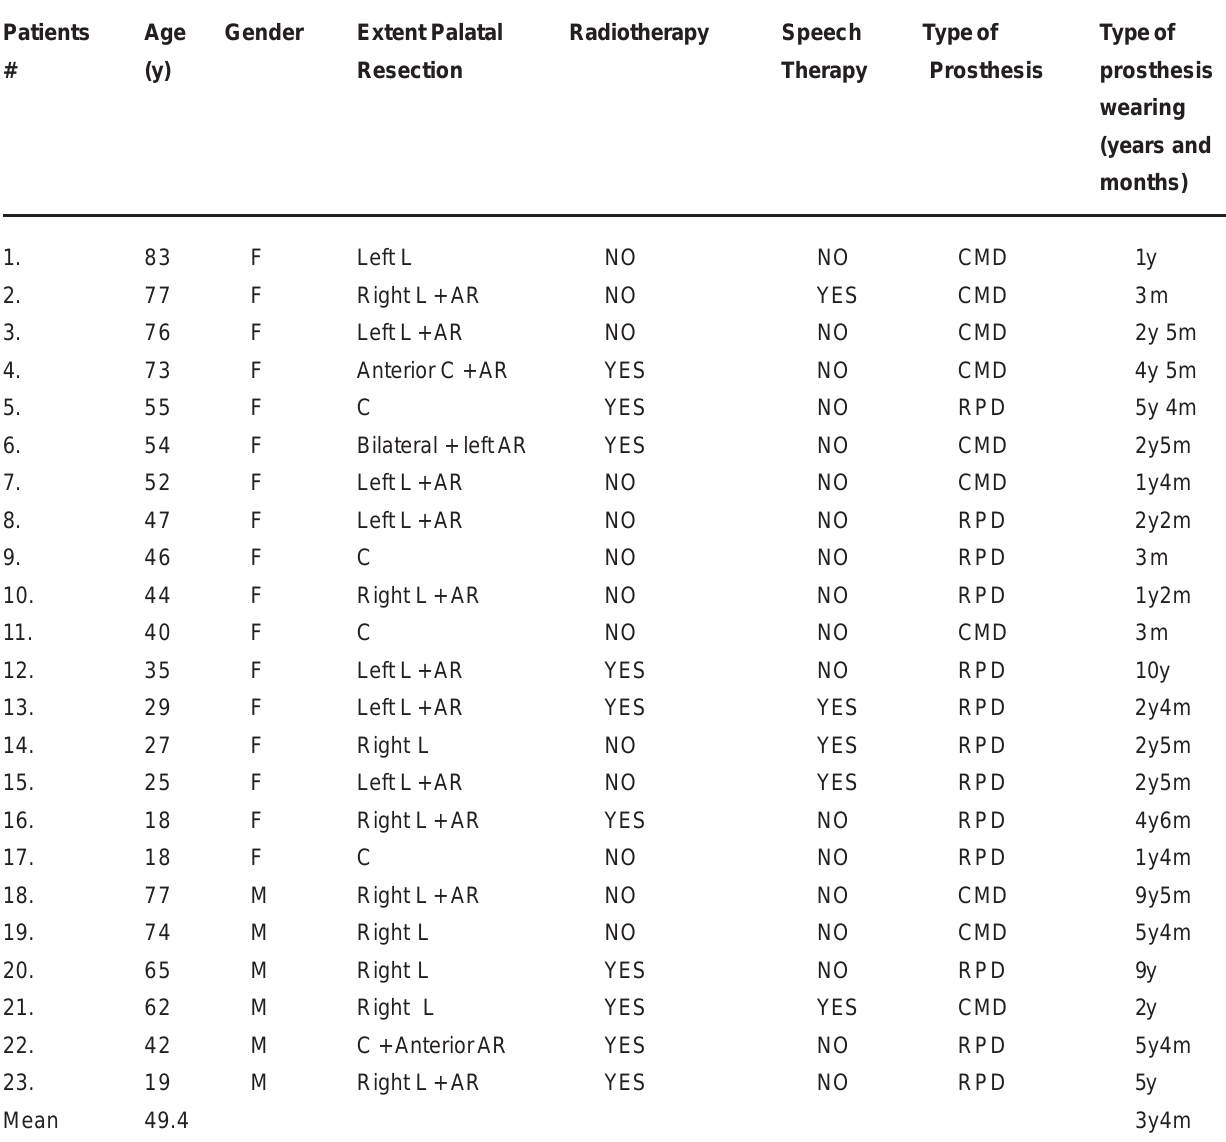
TABLE 1- Biographical data of patients who participated in the